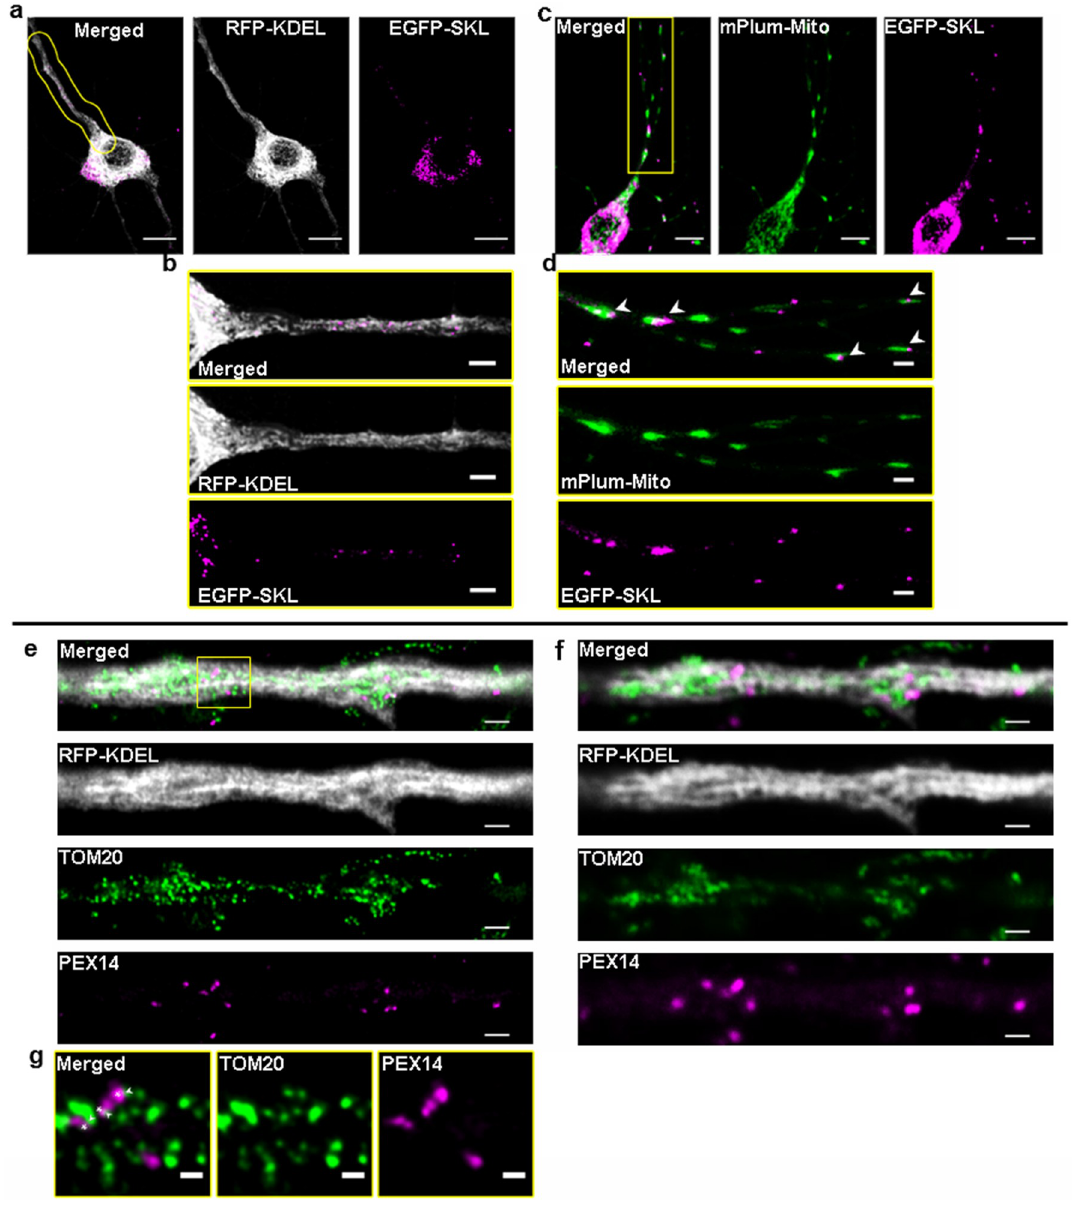
Fig 1. Visualization of PO, mitochondria and ER distribution in hippocampal neurons using confocal and STED microscopy. (a) Overview of a neuron with POs and ER marked by expression of EGFP-SKL (magenta) and RFP-KDEL (grey), respectively using standard confocal microscopy. (c) Overview of a neuron with POs and mitochondria marked by expression of EGFP-SKL (magenta) and mPlum-Mito-3 (green) [30], respectively using live confocal microscopy, shown as maximum intensity projection. Scale bars comprise 10 μ m. (b, d) Magnifications of the areas marked by yellow lines in a, c. Note that POs often appear in close vicinity to the ER and mitochondria (Scale bars: 3 μ m). (e) STED and (f) confocal image of the same neuron showing peroxisomal Pex14 (magenta) and mitochondrial TOM20 (green) (30) antibody staining. The ER (grey) was marked by expression of a RFP-KDEL encoding plasmid (Scale bars: 1 μ m). (g) Magnification of the area marked by a rectangle in (e), maximum pixel resolution in the image is 20 nm, thus signals attached to each other are in the distance characteristic for organelle contact zones (Scale bar: 300nm).